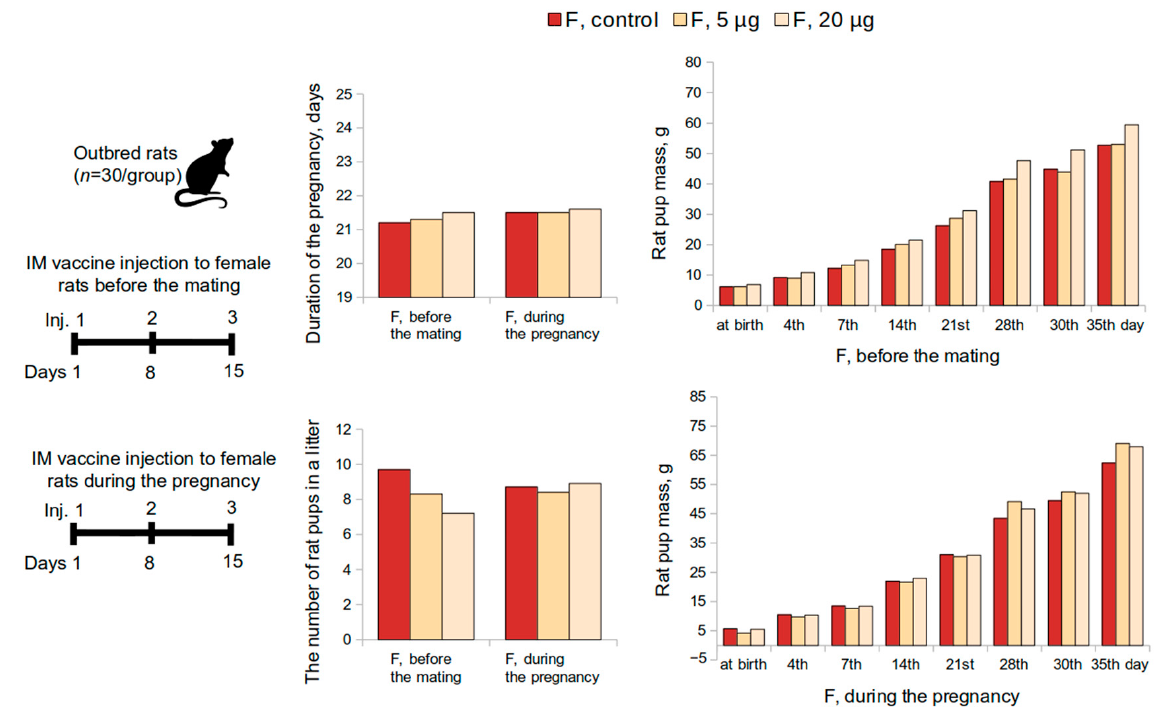
Figure 3. Evaluation of postnatal development of the offspring according to the following parameters: duration of the pregnancy, the number of rat pups in a litter, rat pup mass, when female rats were intramuscularly immunized with the “Betuvax-CoV-2” vaccine 15 days before mating (F, before the mating); during the first 19 days of the pregnancy (F, during the pregnancy). F—females; IM—intramuscular injection; p > 0.05.